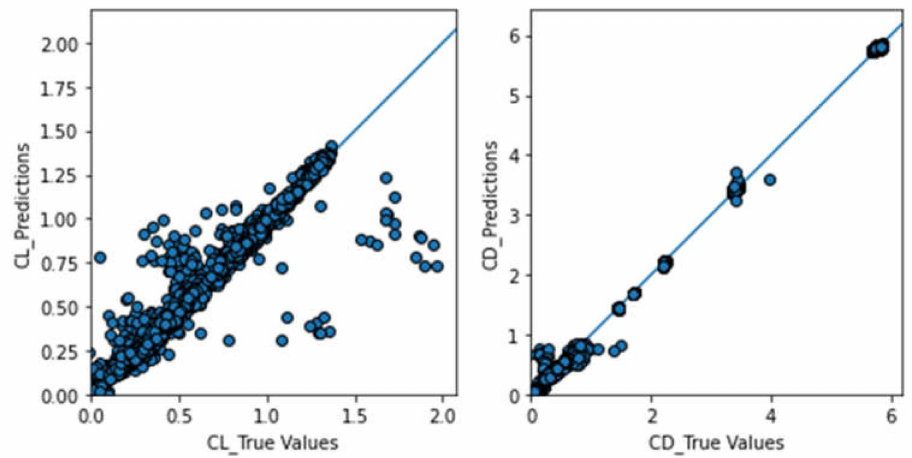
Figure 8. Prediction results with the DNN for the various